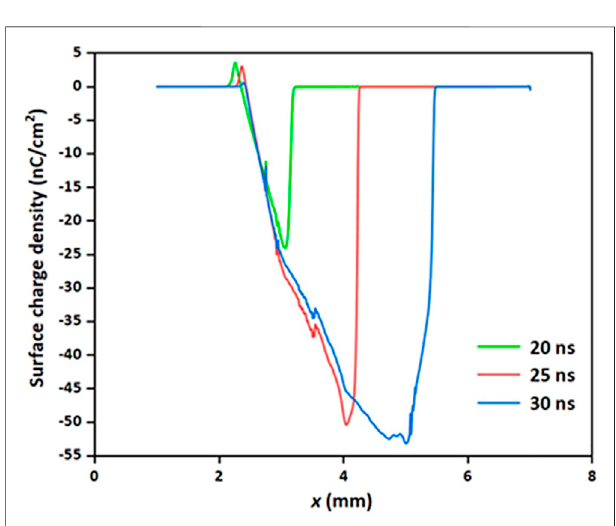
FIGURE 14 | Surface charge density thinner layer of graded